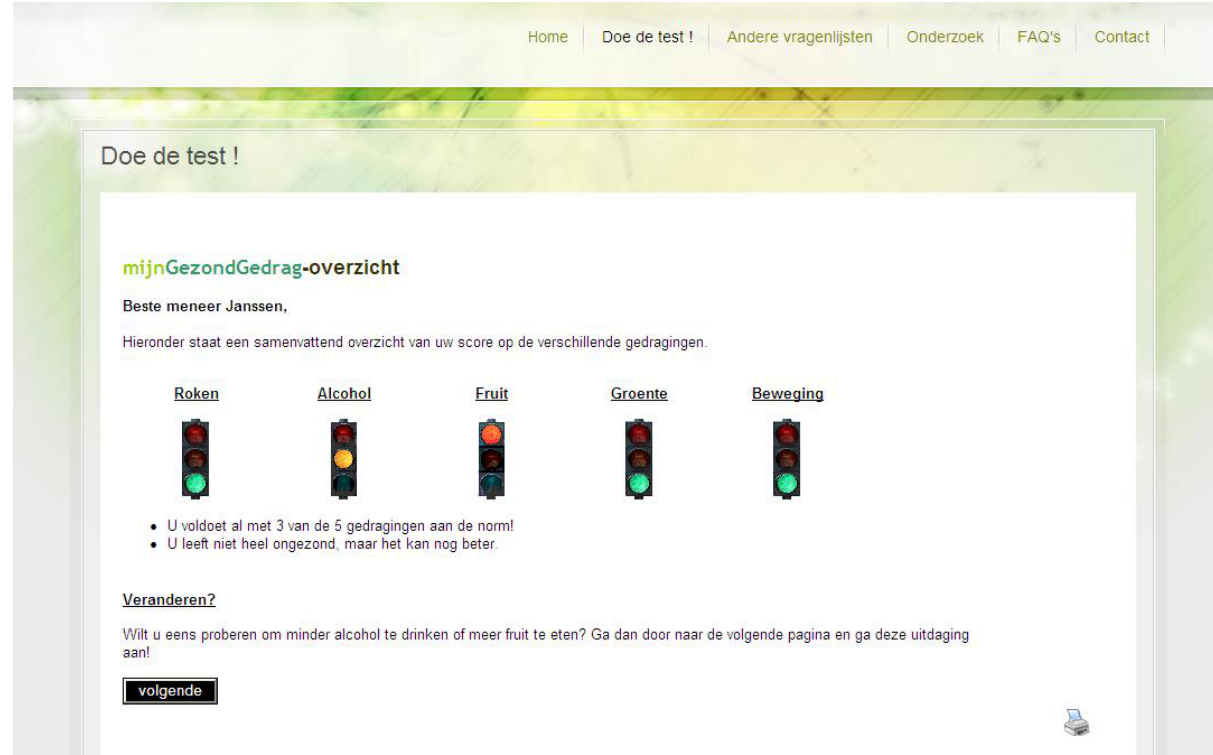
Figure 2. Screenshot of the health risk